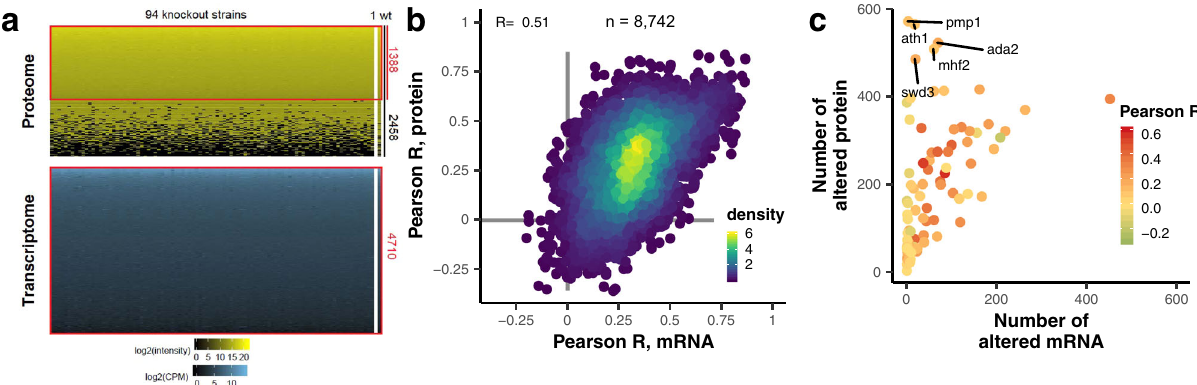
Fig. 4 | Correlation of transcriptome and proteome for 94 selected knockout strains reveals post-transcriptional regulators. a Heatmaps of proteome expression (yellow-black) and transcriptome expression (blue-black) obtained by measuring the same samples by quantitative proteomics and RNA-Seq ( n =4). b ScatterplotofthepairwisePearson ’ scorrelationcoef fi cientsbetweenallpossible knockoutstrainpairs( n =8742)atthetranscriptomeversusproteomelevelsshows